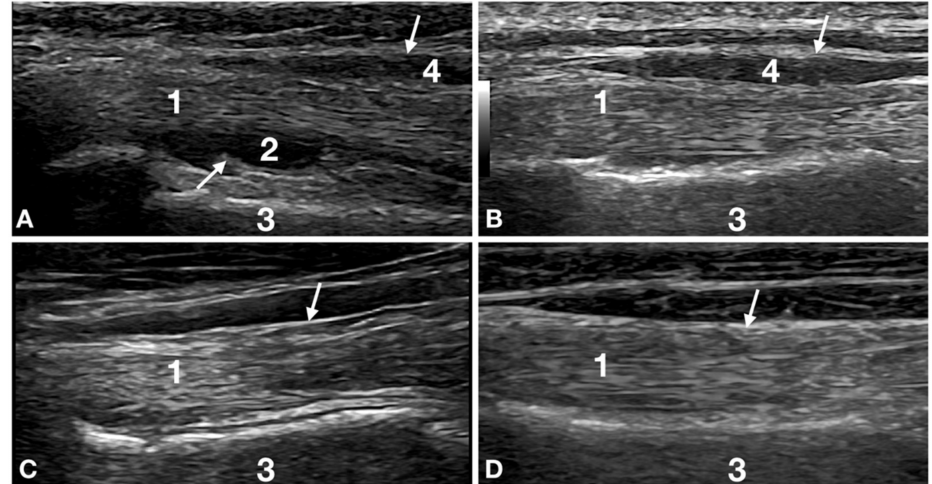
Figure 1. Images of the right biceps tendon distal to the bicipital groove of patient number 12 at Time 0, Time 2, Time 4 and Time 6 are reported. The image shows the progression of healing. ( A ) Time 0: biceps tendon (1) is not uniform in diameter with a poor fibrillar pattern. The tendon is less echoic with fewer, less defined, thin, hyperechoic lines running along its longitudinal axis. Shoulder effusion (2) is seen between the deeper interface of the tendon and the cranial humeral surface (3). Tendon sheath thickening (arrows) and effusion (4) are evident. ( B ) Time 2: the biceps tendon (1) is more uniform in diameter thickness but is not the same as the contralateral (not shown but similar to panel d). The fibrillar pattern is mildly increased, and the tendon is more homogeneous and echoic. The shoulder effusion has resolved. The superficial tendon sheath (arrow) is still moderately thickened with mildly reduced effusion (4). ( C ) Time 4: the biceps tendon (1) is more echoic and is uniform in thickness, with a diameter comparable with the contralateral limb. The fibrillar pattern is better defined but still not identical to the contralateral tendon (compared with panel d). The superficial tendon sheath (arrow) is back to normal for thickness, and there is no visible effusion. ( D ) Time 6: the biceps tendon (1) is echoic with a fine fibrillar pattern, typical of tendons. The echotexture, echogenicity and thickness are identical to the contralateral limbs (not shown). The superficial tendon sheath (arrow) is back to normal for thickness, and there is no visible effusion. All the lesions are resolved, and no degenerative changes are seen in this